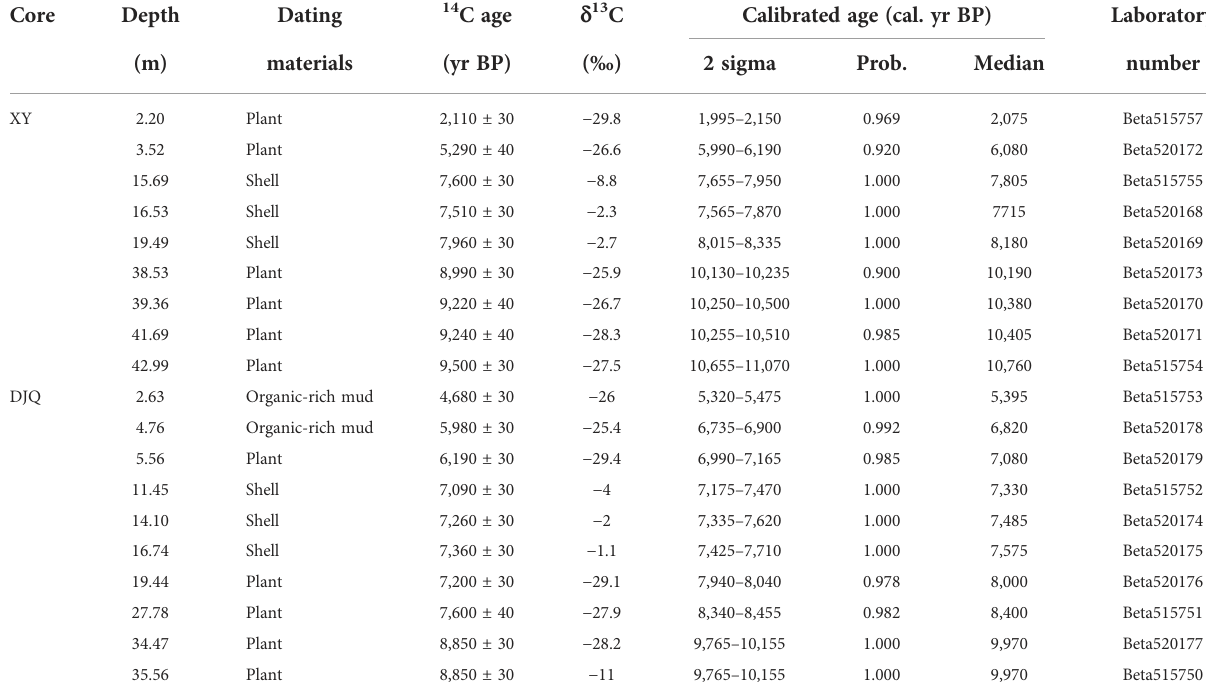
TABLE 1 AMS 14 C ages and their calibrations for cores XY and